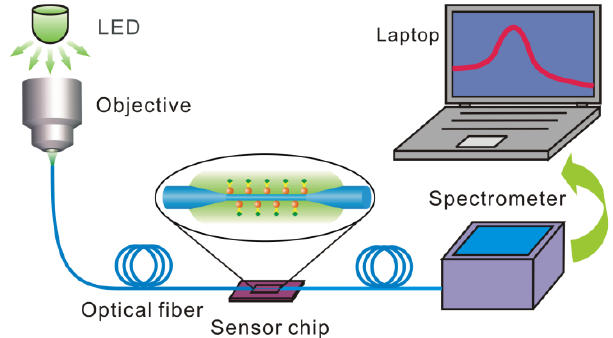
Figure 3. The schematic diagram of the experimental setup.